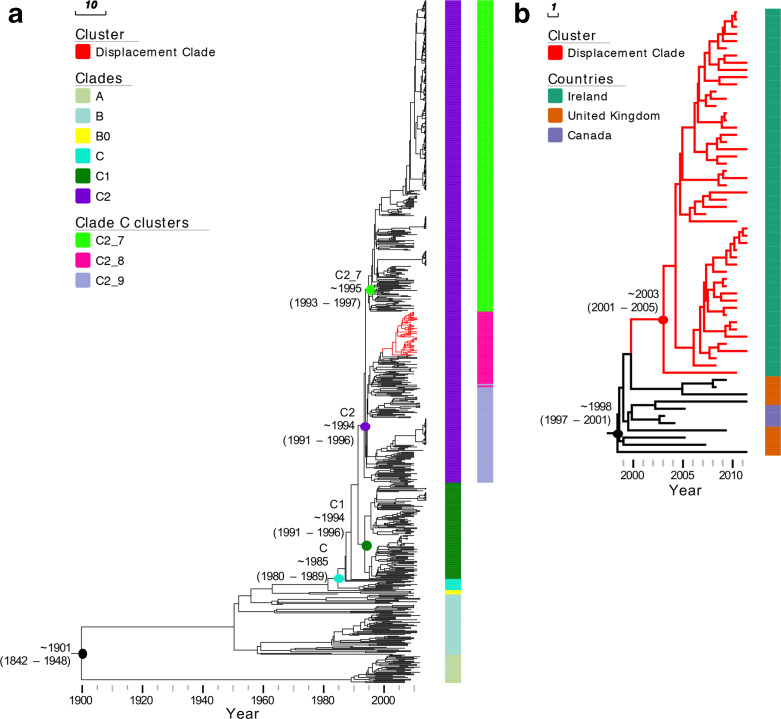
Bayesian maximum clade credibility tree of
E. coli
 ST131 isolates. (a) Phylogeny of 794 isolates analysed in this study. The tree is annotated with columns representing major phylogenetic clades (Clades) as well as subclades within clade C (clade C clusters). The estimated TMRCA for major clades is shown on the tree. Branches of the cluster representing isolates from the Irish LTCF displacement clone are shown in red. (b) A higher resolution view of the Irish LTCF displacement clone, annotated with colour strips representing the isolate’s country of origin.